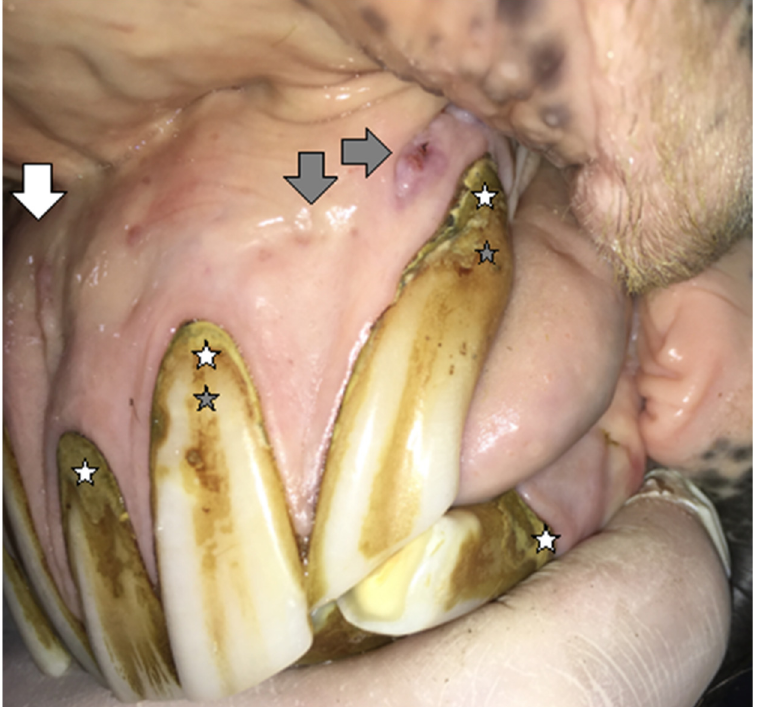
Figure 1. Case 1—The condition of maxillary incisors before extraction. Deformation of the incisal area, a depressions between the ridges of bone formed by roots in the alveolar process on the maxilla, called prominent juga (white arrow). Excessive calculus deposition (white stars), periodontic fistulas (gray arrows), and recessing gumlines (gray stars).